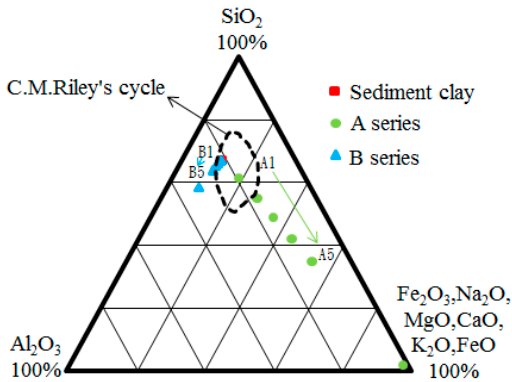
Figure 2. Ternary phase diagram of the chemical compositions of the test materials.